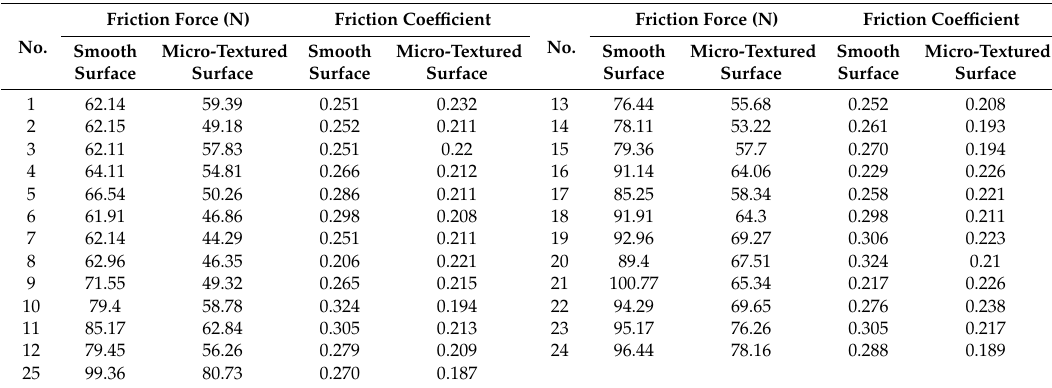
Table 6. Test values of friction force and friction coefficient.